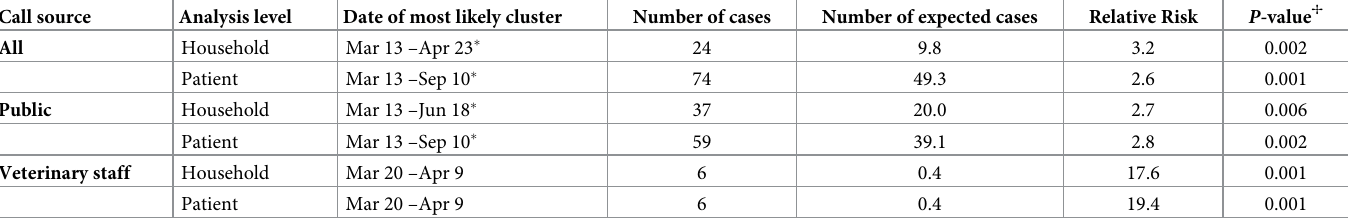
� Indicates cluster detected with a start date prior to voluntary recall on March 16, 2007. ✢ Monte Carlo (9999 replications) based P -value. 1